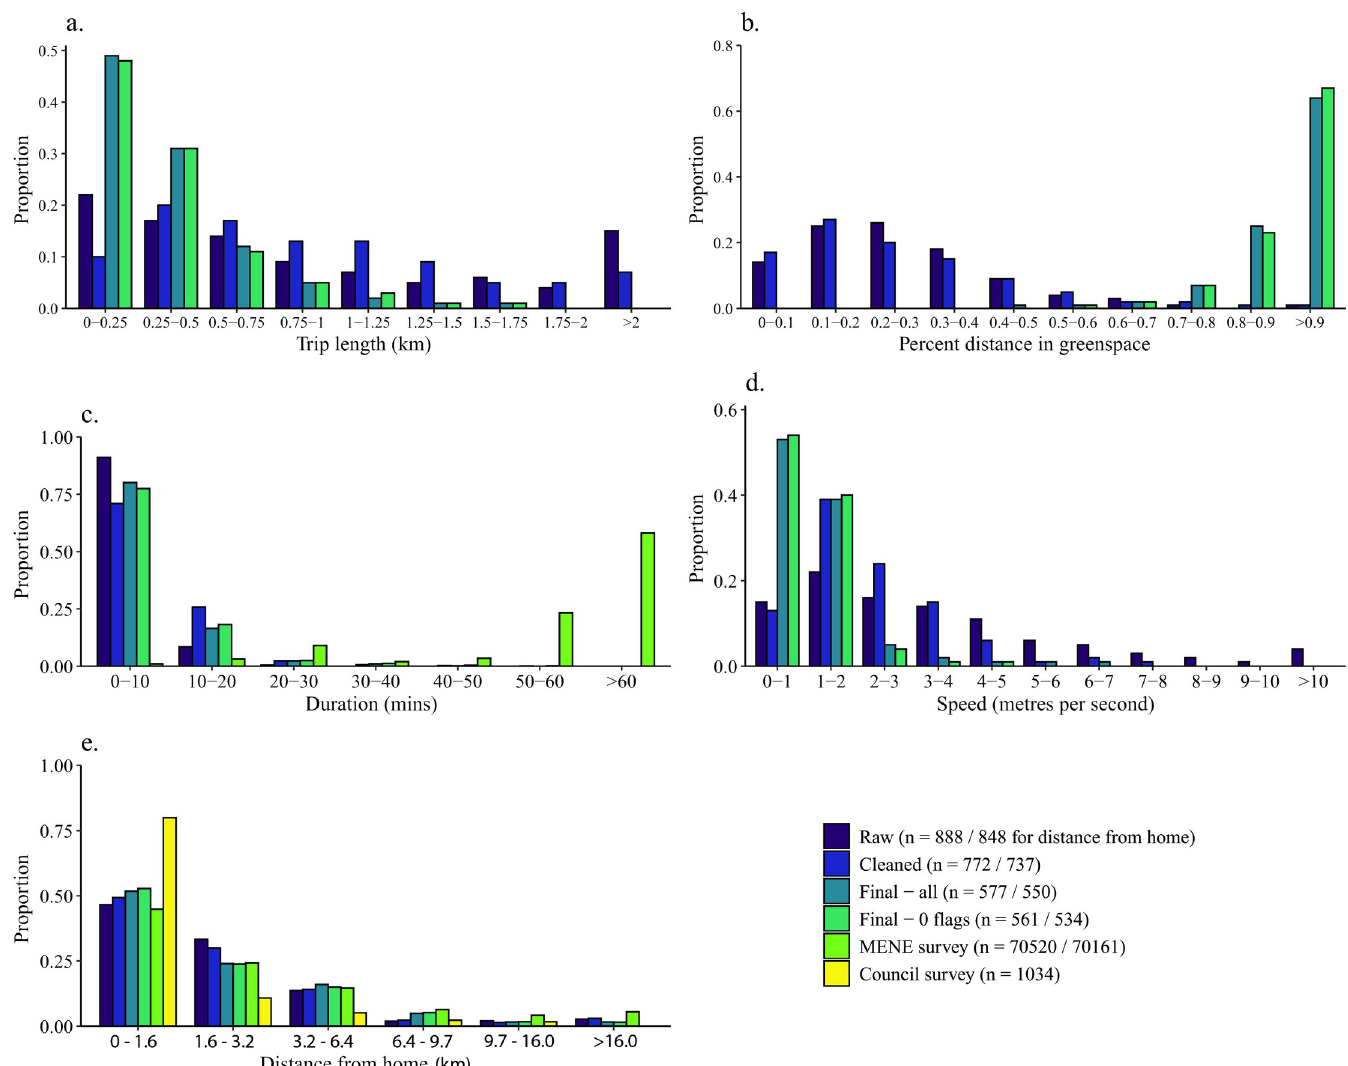
Fig 4. Distribution of trip data characteristics at various stages of processing, averaged by user showing (a) trip length; (b) proportion of the trip in greenspace; (c) trip duration; (d) trip speed; (e) distance from home location. Where available, Monitor of Engagement with the Natural Environment (MENE) (c and e only) and Sheffield City Council survey data (e only) are also shown for comparison. NB distance from home uses imperial units to match intervals from MENE and Sheffield City Council